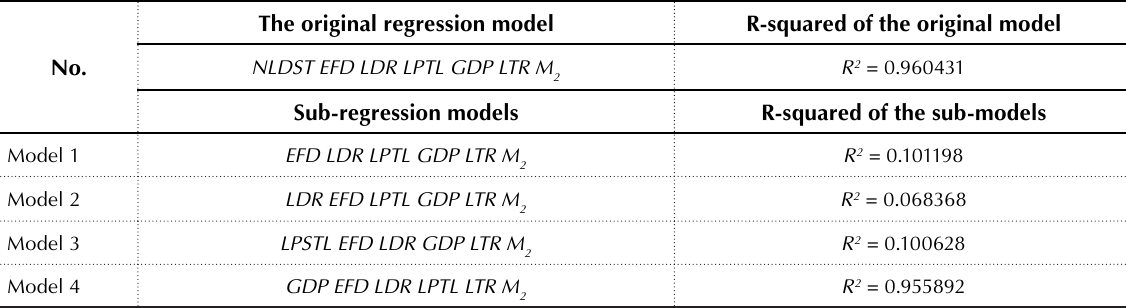
Table B3. R-squared value of